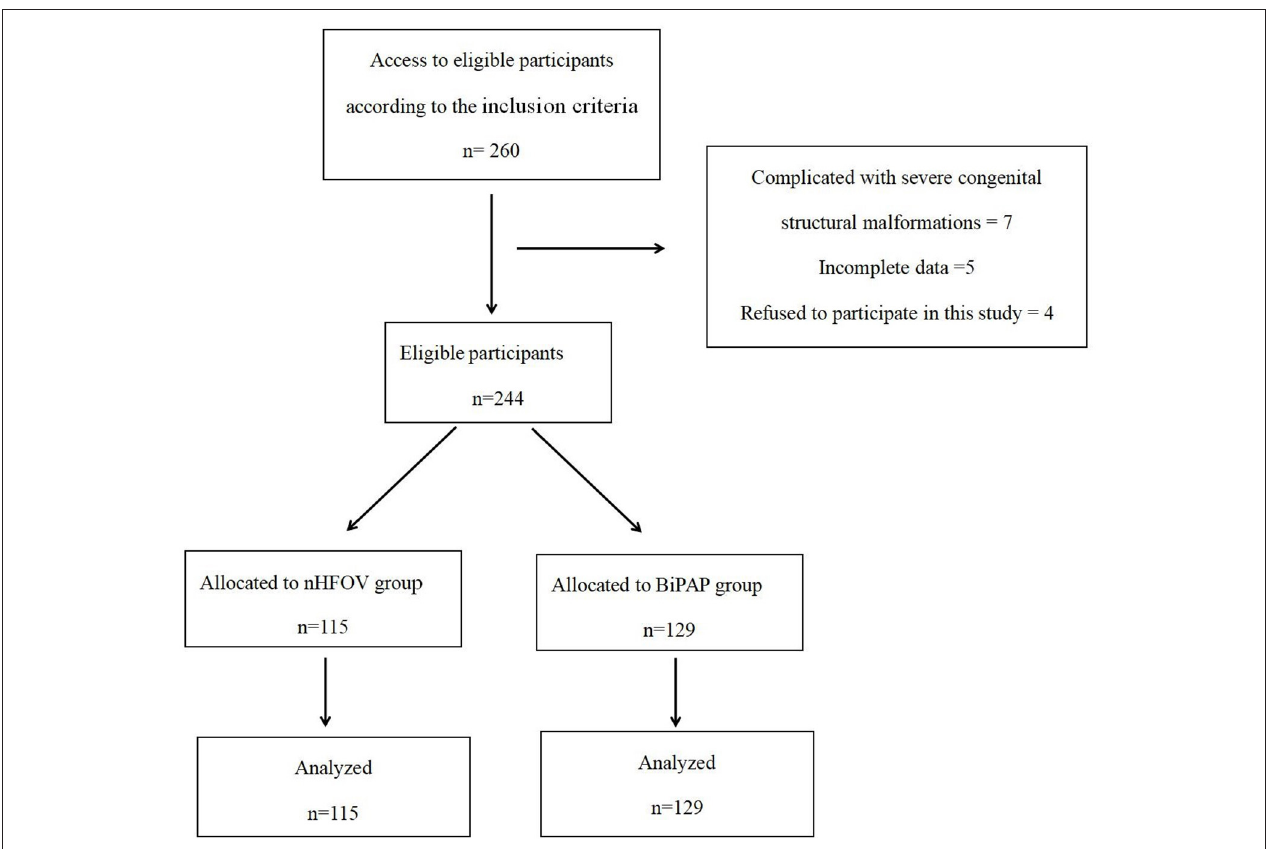
FIGURE 1 | The patient flow diagram of the